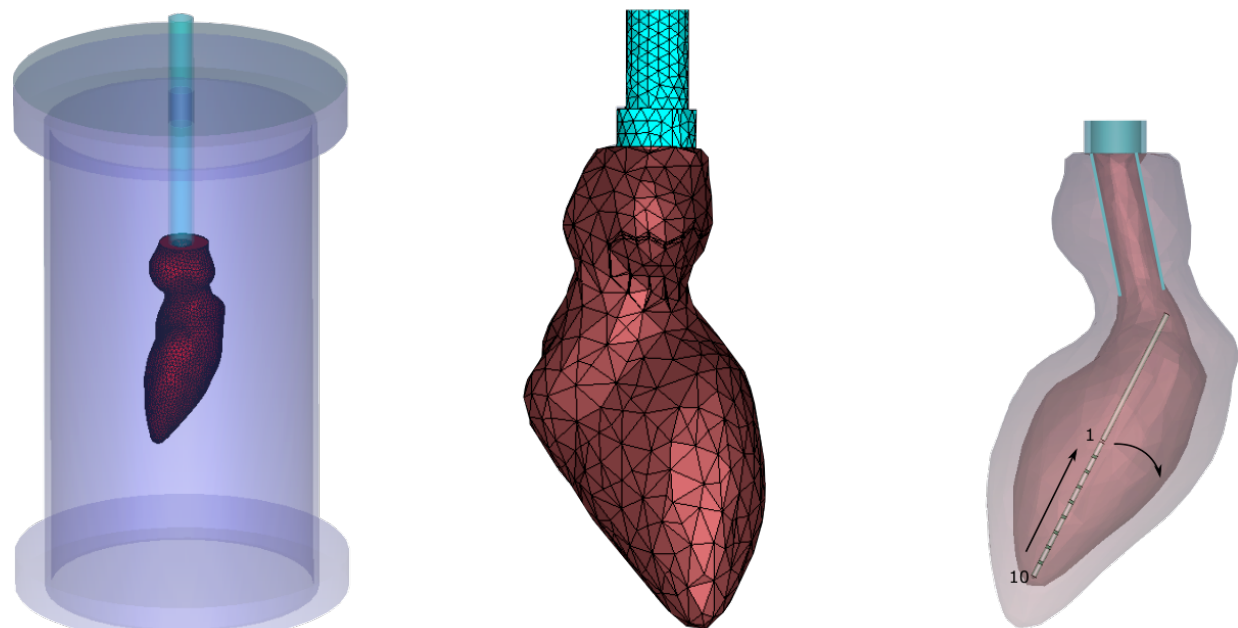
Fig.3: Left: In silico FE model similar to the in vitro model from CAD files; middle: Mesh view of the FE model; right: Close-up of the ventricle’s longitudinal cross-section with the ten-electrode